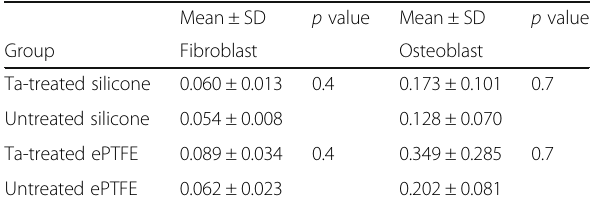
Table 1 Cell viability assessment